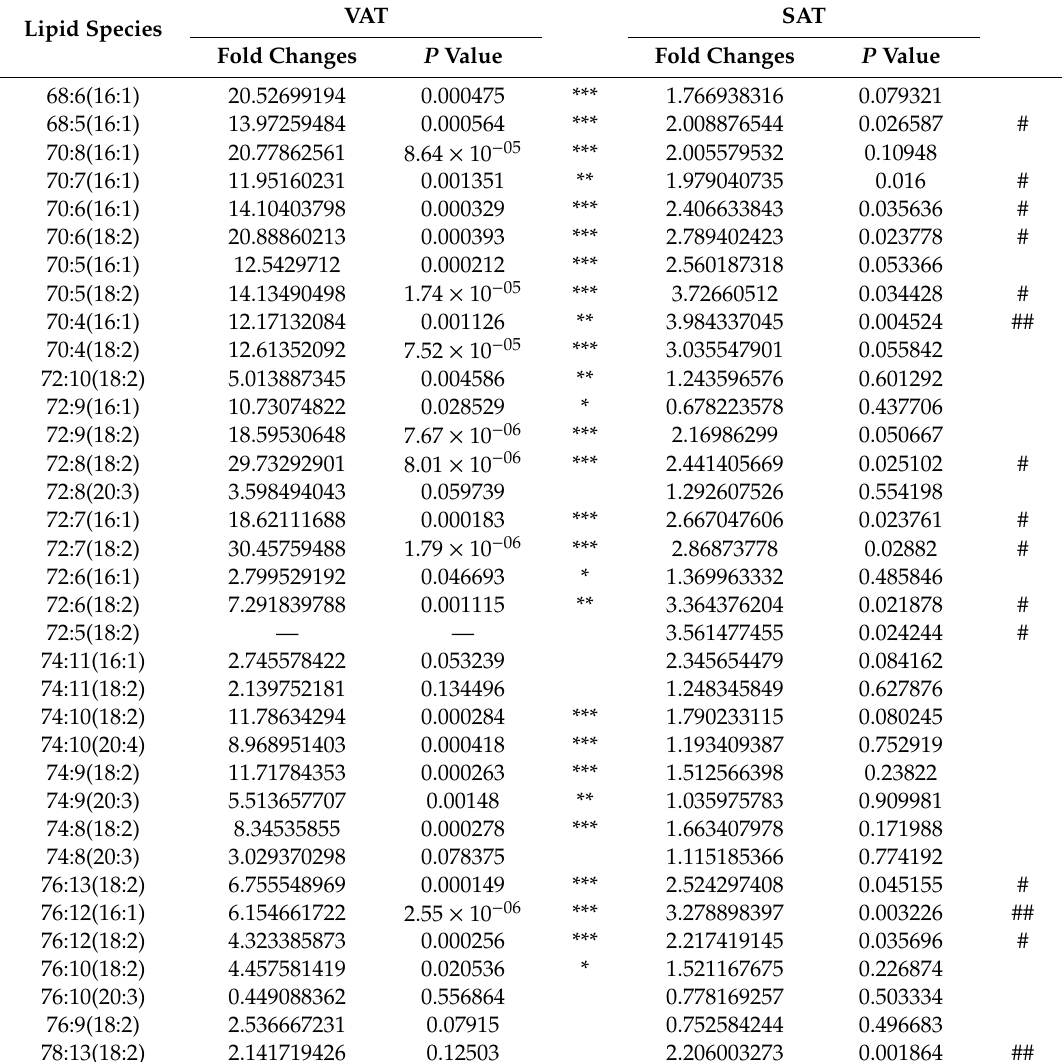
Table 1. Changes of cardiolipin species in VAT and SAT of mice under CL316,243 stimulation. Lipid